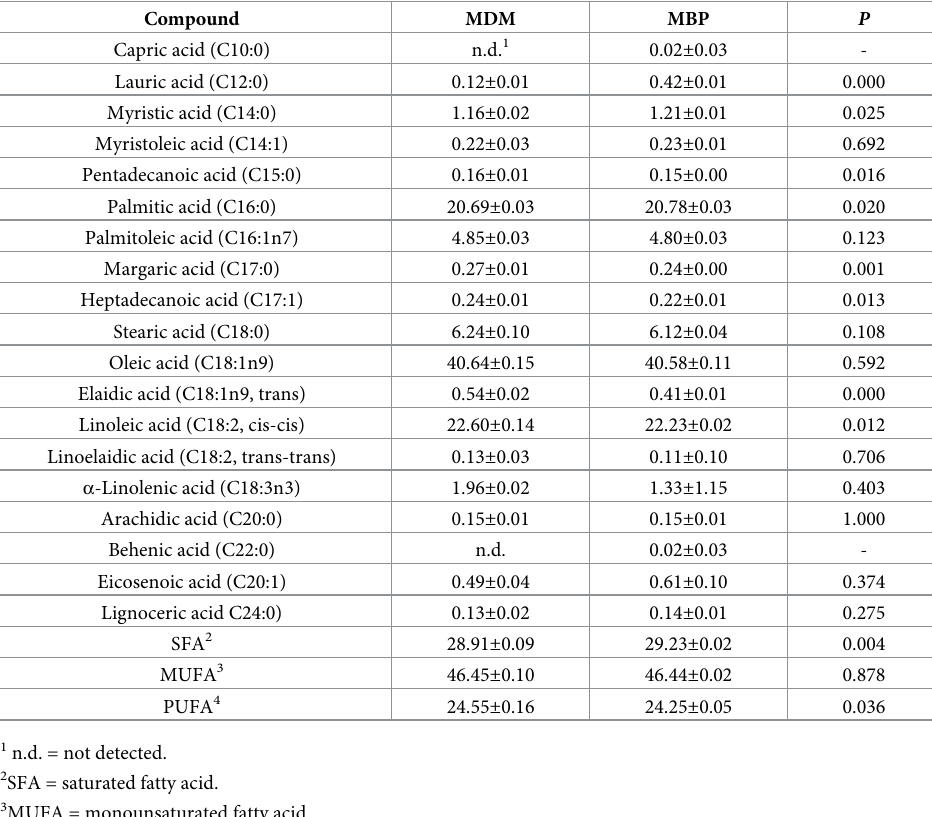
Table 5. Fatty acid profile (mean ± SD; g/100 g of total fatty acid) of the two diets (MDM = Mechanically Deboned Meat; MBP = Meat By-Products) and the significance between them. Compound MDM MBP P Capric acid (C10:0) n.d.